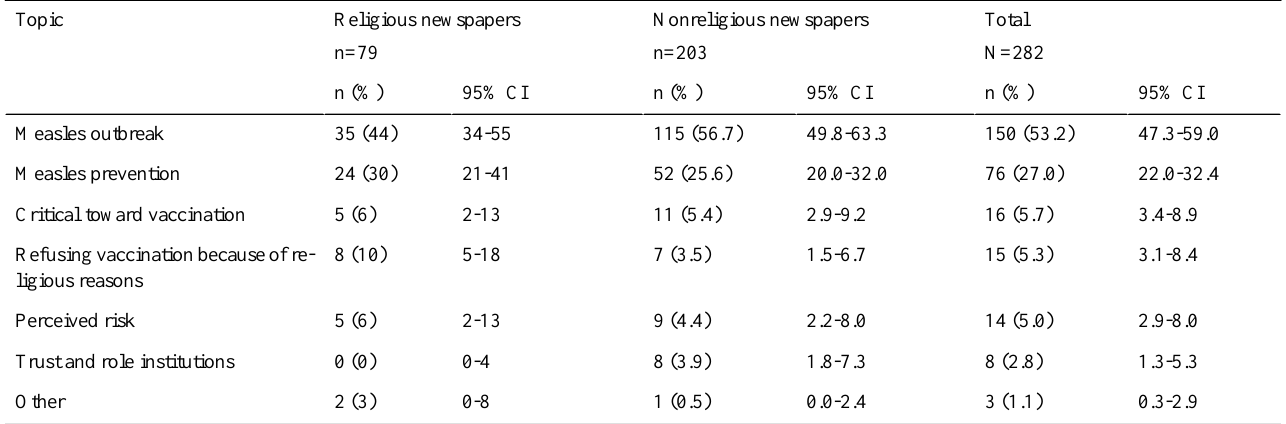
Table 5. Topics of coded measles-related articles in religious- and nonreligious-oriented